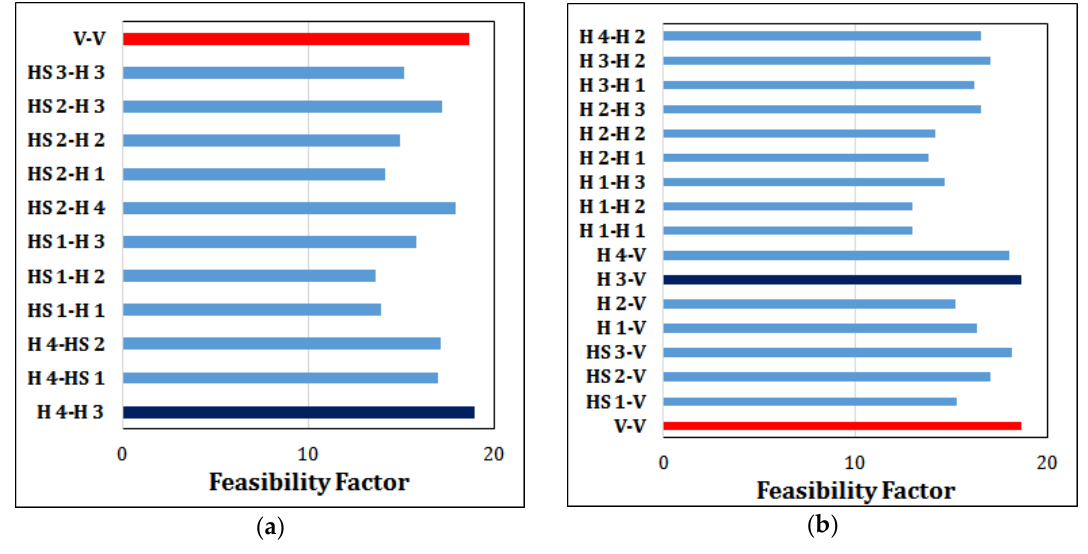
Figure 2. Comparison of the values of FF between the combinations in Category A and the reference case: ( a ) HS-H, H-HS and H-H groups; ( b ) H-H group, H-V case and HS-V group.